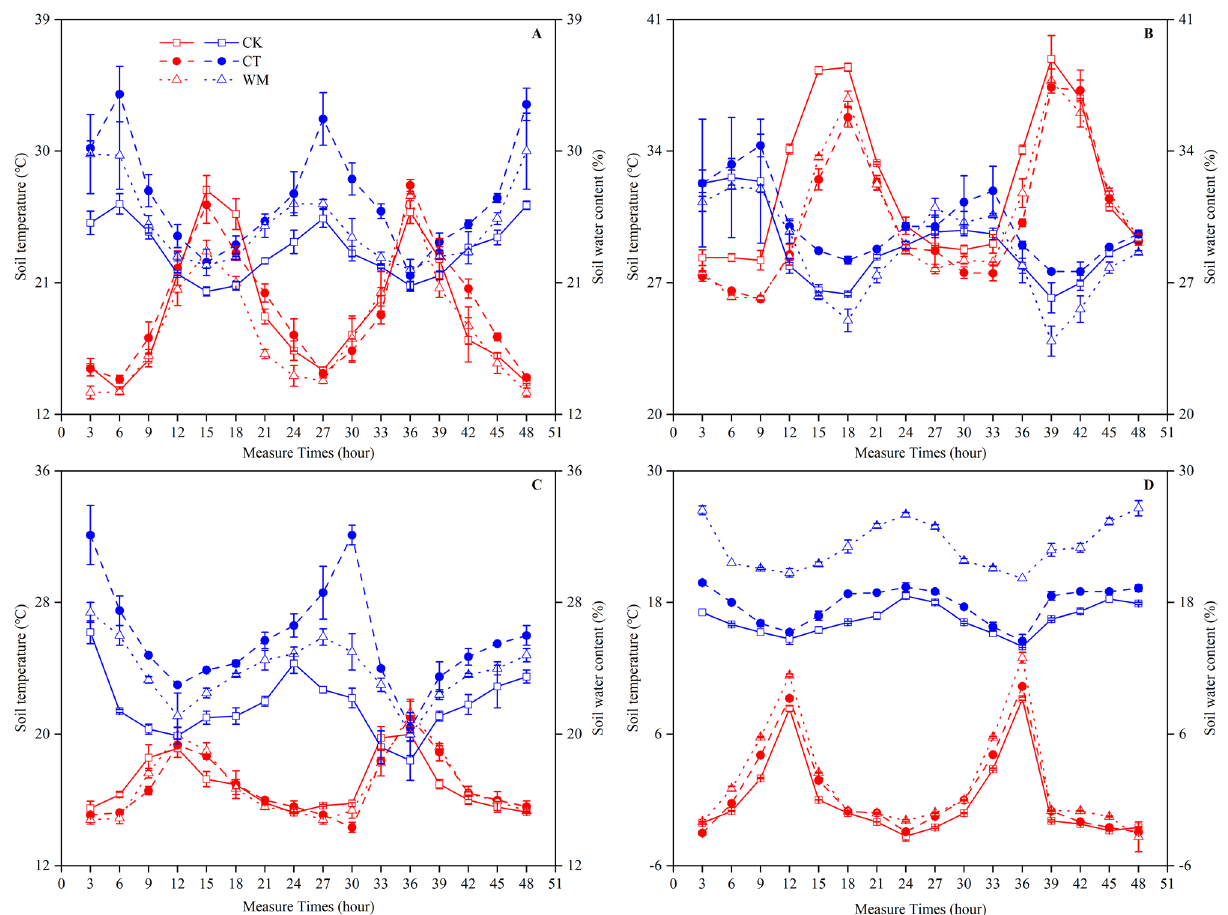
Figure 1. Dynamics of the soil temperature (red colour) and soil water content (blue colour) at a 0–10 cm soil depth in April ( A ), August ( B ), October ( C ) and December ( D ) at the study sites. CK, natural coastal wetland; CT, cotton mono-cropping farmland; WM, wheat–maize rotation farmland. Vertical bars represent ± SD of the mean (n = 3).